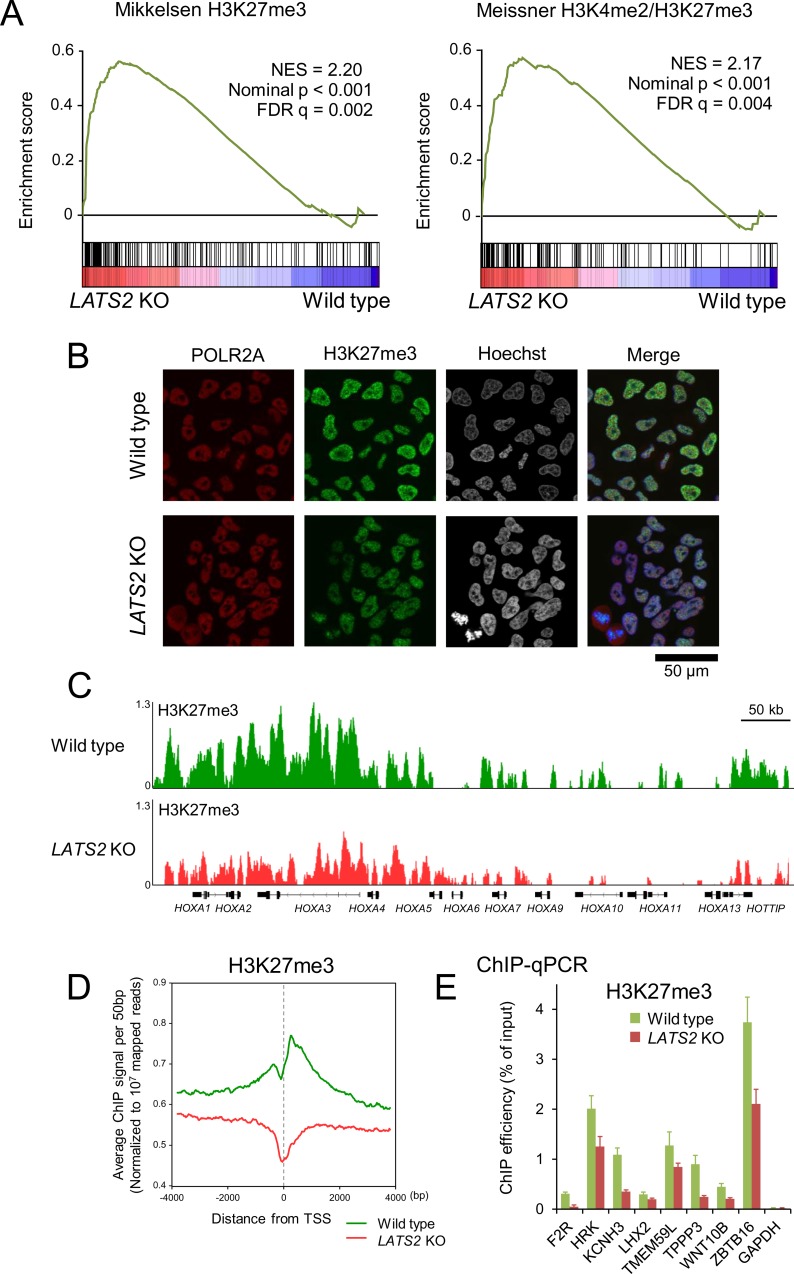
Dysregulation of H3K27me3 regulation upon LATS2 KO.(A) GSEA of LATS2 KO HeLa-S3 cells for gene sets related to H3K27me targets. Genes are ranked by fold change in a RNA-seq experiment (KO vs. wild type). A positive enrichment score indicates higher expression after LATS2 KO. (B) Immunofluorescence showing reduction of global H3K27me3 in LATS2 KO HeLa-S3 cells relative to the wild type. RNAPII and nuclei were counterstained. Bar indicates 50 μm. (C) Snapshots of ChIP-seq traces for H3K27me3 in the wild type HeLa-S3 (green) and LATS2 KO cells (red). The HOXA gene cluster is depicted as a representative locus showing a reduction of H3K27me3 following LATS2 KO. (D) Aggregate plots of H3K27me3 ChIP-seq signals centered at TSSs of all RefSeq genes in wild type HeLa-S3 (green) and LATS2-KO cells (red). (E) ChIP-qPCR analysis for H3K27me3 on a series of known PRC2 target loci. All ChIP experiments were performed at least twice independently; error bars show SD.